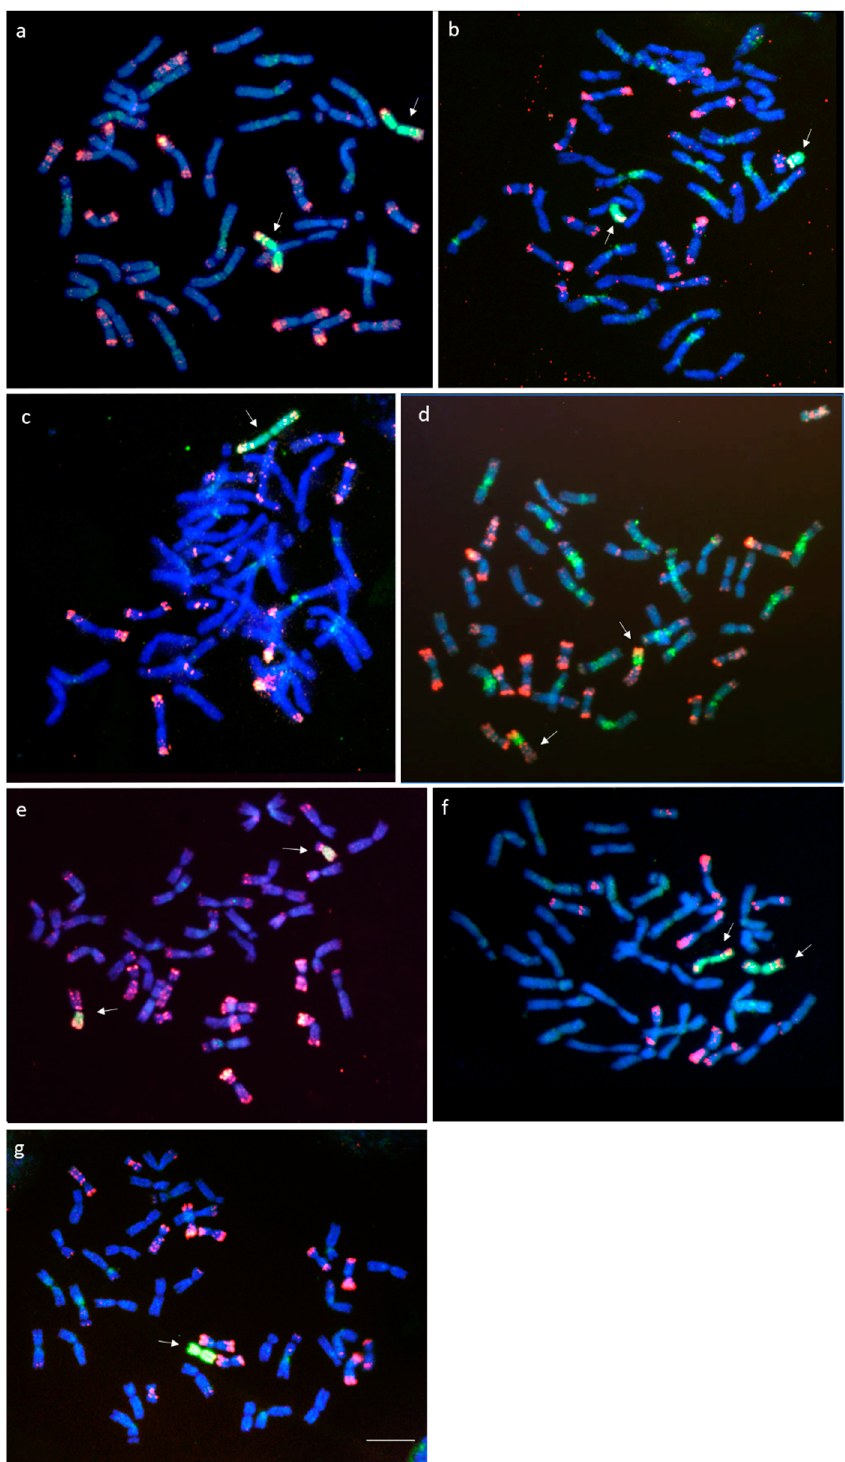
Figure 1. Fluorescence in situ hybridization (FISH) with the pAs1 repetitive (red) and H. chilense genomic DNA (green) probes to mitotic metaphase of wheat— H. chilense introgression lines involving chromosome 2H ch . ( a ) Disomic substitution 2H ch (2D); ( b ) Ditelosomic 2H ch L; ( c ) Isochromosome 2H ch L; ( d ) Translocation 2H ch S · 2DL; ( e ) Translocation 2H ch S · 2DL + T7H ch S · D; ( f ) Translocation 7H ch S · 2H ch L; ( g ) Translocation 2H ch L · 7H ch L. Bar = 10 µm.